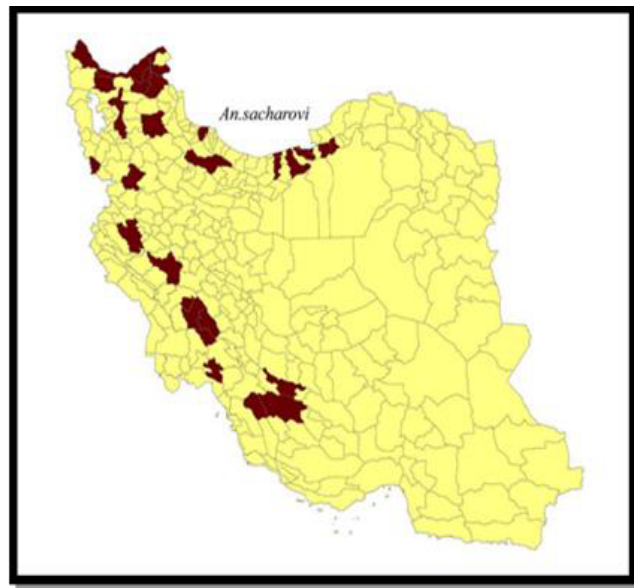
Figure 1: Distribution map of Anopheles sacharovi in